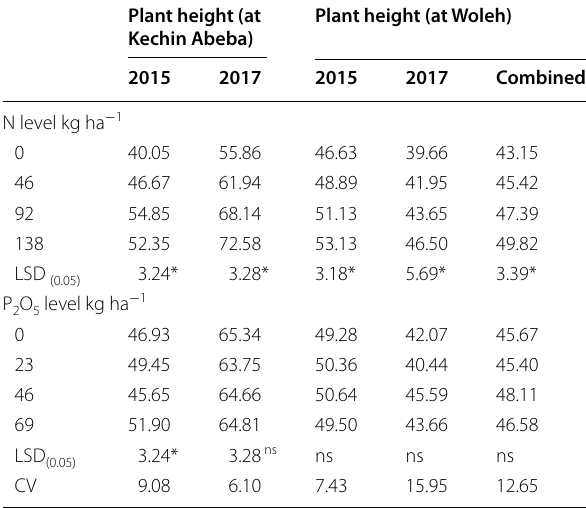
ns non-significant, * and ** significant and highly significant respectively